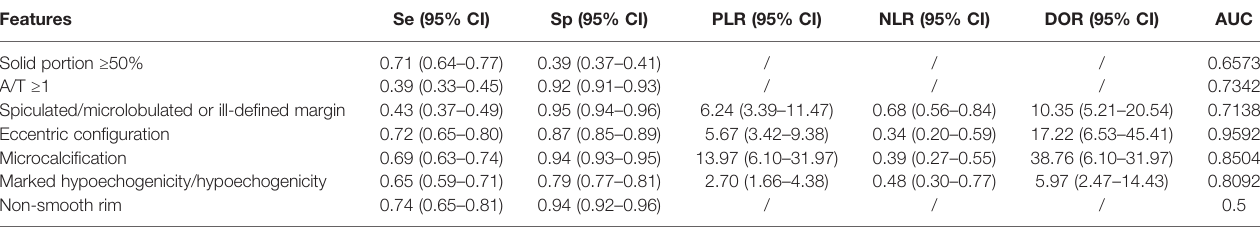
TABLE 2 | Diagnostic performance of each malignant feature.